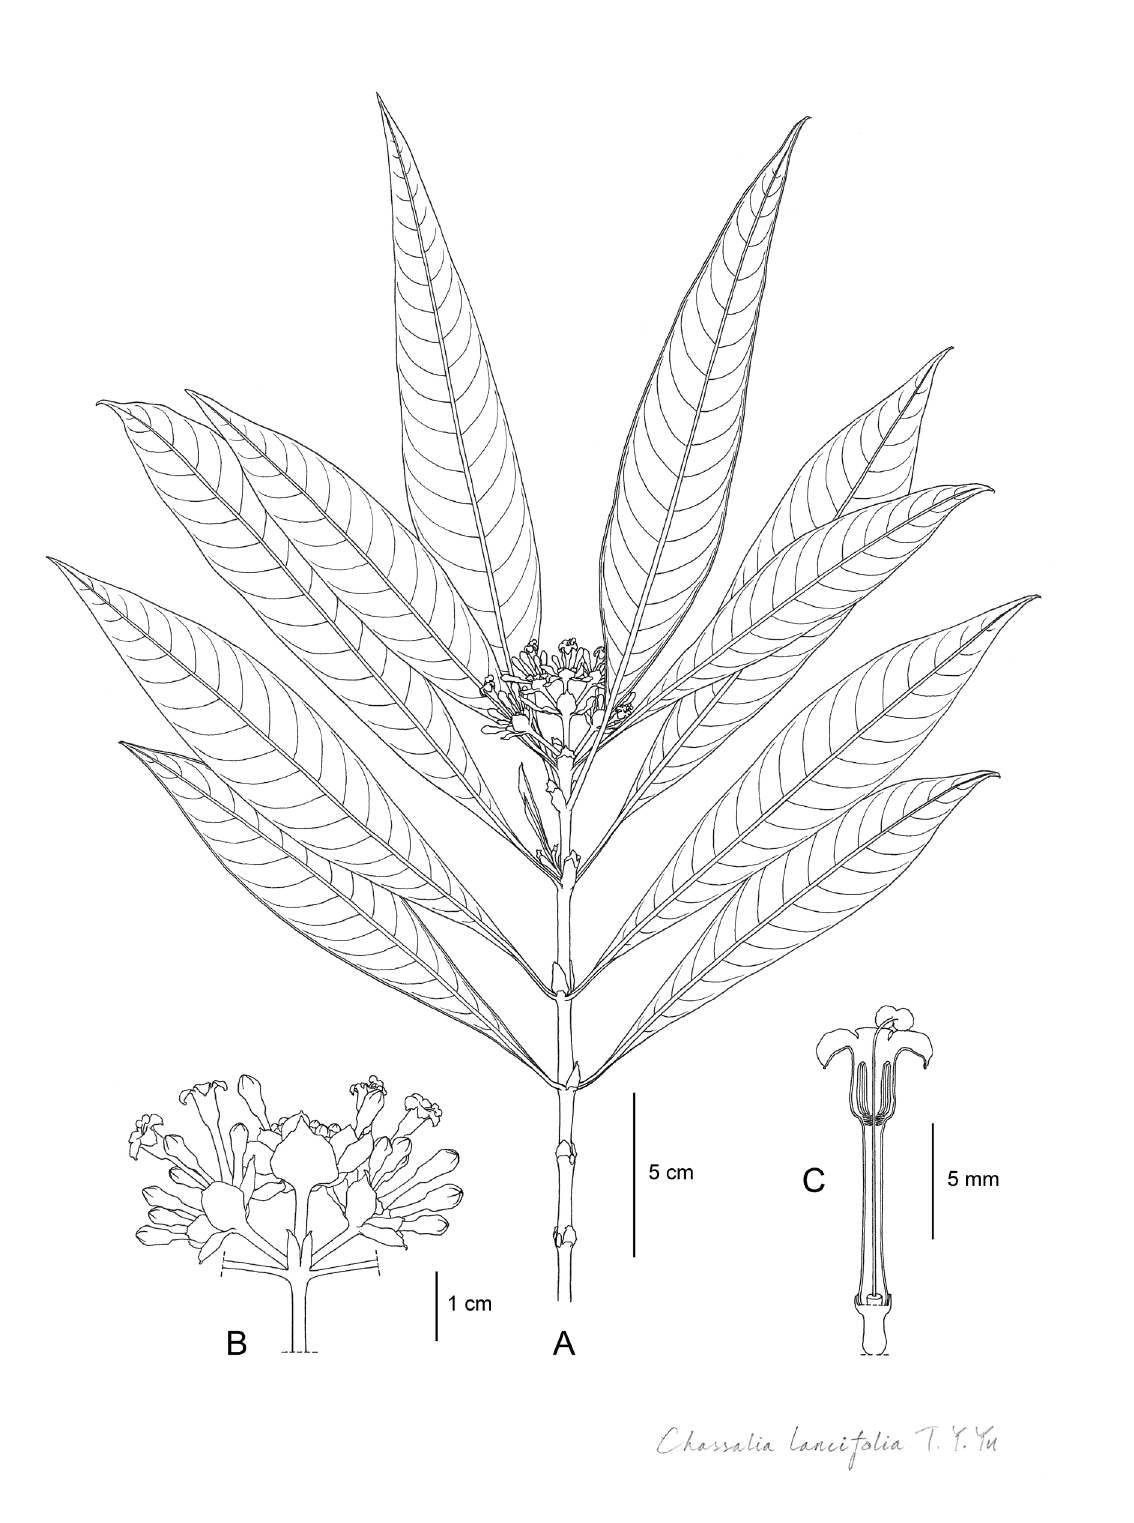
Fig. 16. Chassalia lancifolia T.Y.Yu sp. nov. A . Flowering shoot. B . Central branch of inflorescence. C . Longitudinal view of corolla showing stamens, band of hairs, stigma, style and disc. From H.N. Ridley s.n. (K001129713). Drawn by T.Y.